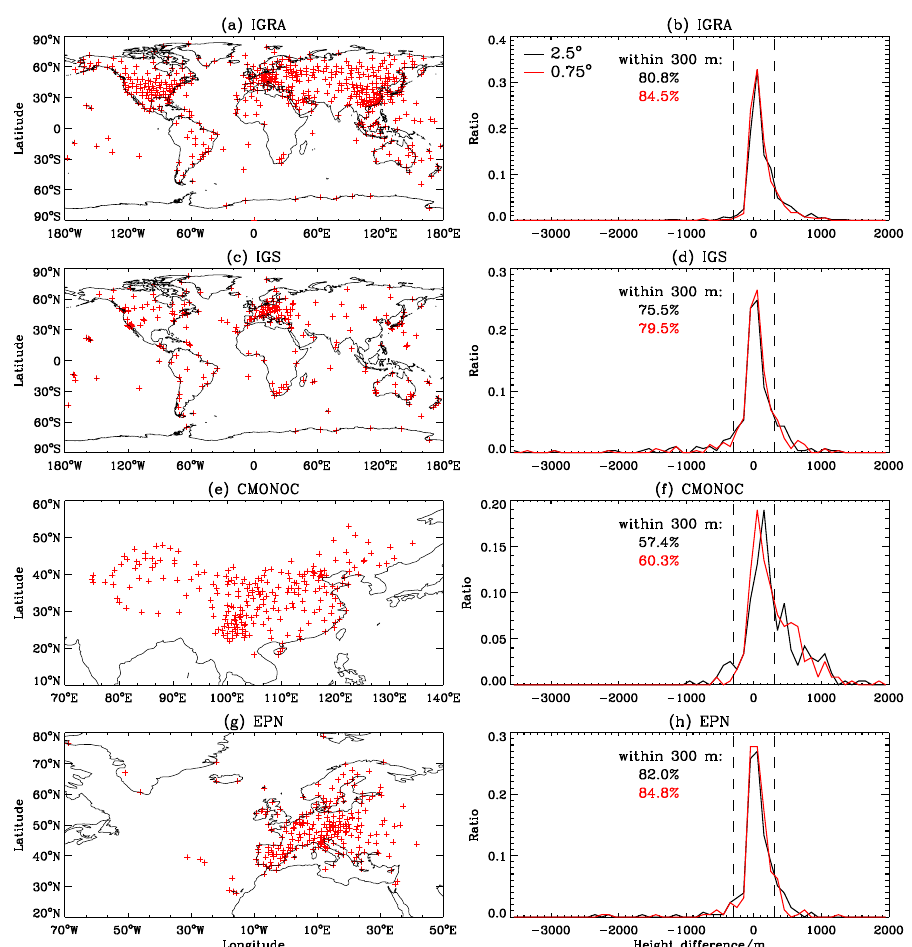
Figure 1. Geographic locations of IGRA ( a ), IGS ( c ), CMONOC ( e ), and EPN ( g ) stations used in this study. ( b , d , f , h ) show normalized histograms of height differences between ERA surface data grids and observation stations of IGRA, IGS, CMONOC, and EPN, respectively. In ( b , d , f , h ), the black lines refer to results for the 2.5° × 2.5° grid while the red lines refer to those for the 0.75° × 0.75° grid. The percentages of height differences within ±300 m are also displayed, black for the resolution of 2.5° × 2.5° and red for the resolution of 0.75° × 0.75°.